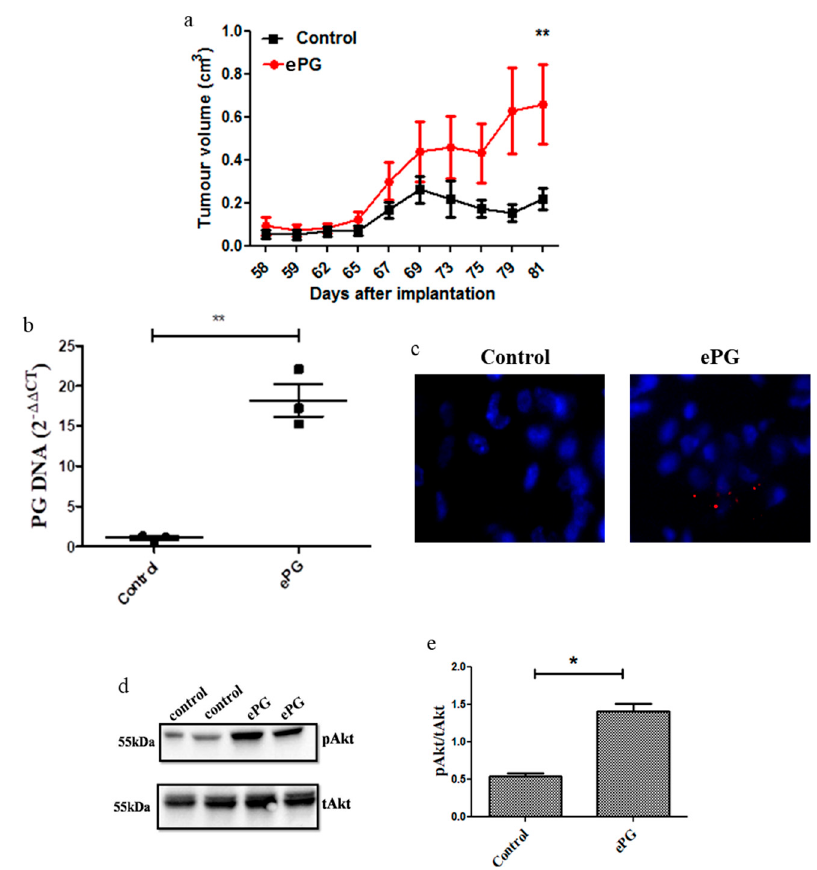
Figure 6. P. gingivalis enhances tumor growth and Akt phosphorylation. ( a ) PANC1 cells were incubated in hypoxia and infected with ePG or sham infected, and then injected subcutaneously to SCID mice ( n = 7 per group). From the time tumors were palpable and through 11 weeks, tumor volume was monitored daily (in the control group one mouse did not develop a tumor and was not included in the analysis). ( b ) Following sacrifice on day 81 post implantation, tumors ( n = 3 per group) were frozen and DNA was extracted as per the methods. RT PCR was performed using primers for the 16s P. gingivalis rDNA gene and the human 18S gene. Relative expression was calculated using the 2- ΔΔ CT method. ** p = 0.0011. ( c ) For each group, three tumors were fixed in 4% paraformaldehyde and then embedded in OCT. Frozen sections were stained with a Cy3-labeled oligonucleotide specific for the P. gingivalis 16s rRNA gene (red), and nuclei were counterstained with DAPI (blue). Representative images of one control and one P. gingivalis -infected tumor at 20× magnification are shown. ( d , e ) Tumor protein lysates from two mice in each group were analyzed by Western blot for Akt phosphorylation ( d ) and protein levels were determined by densitometry ( e ). * p ≤ 0.05, ** p ≤ 0.01.